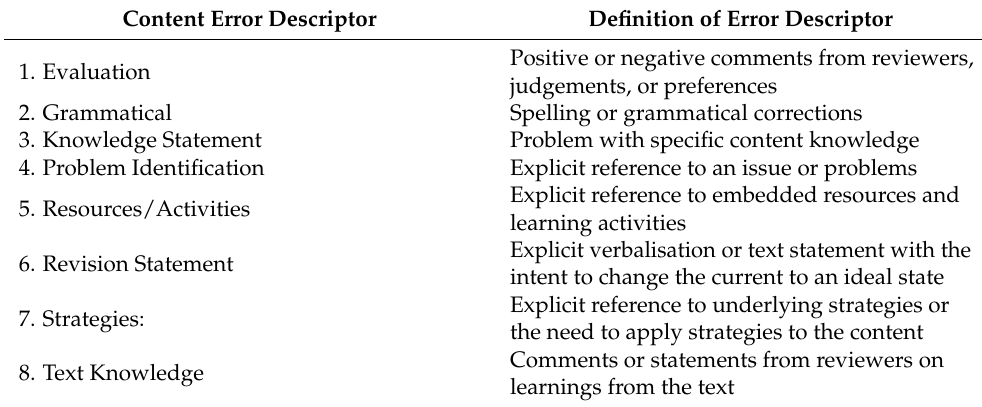
Table 1. Content-specific error descriptors applied to feedback generated by expert review groups (modified Sayoran 1992